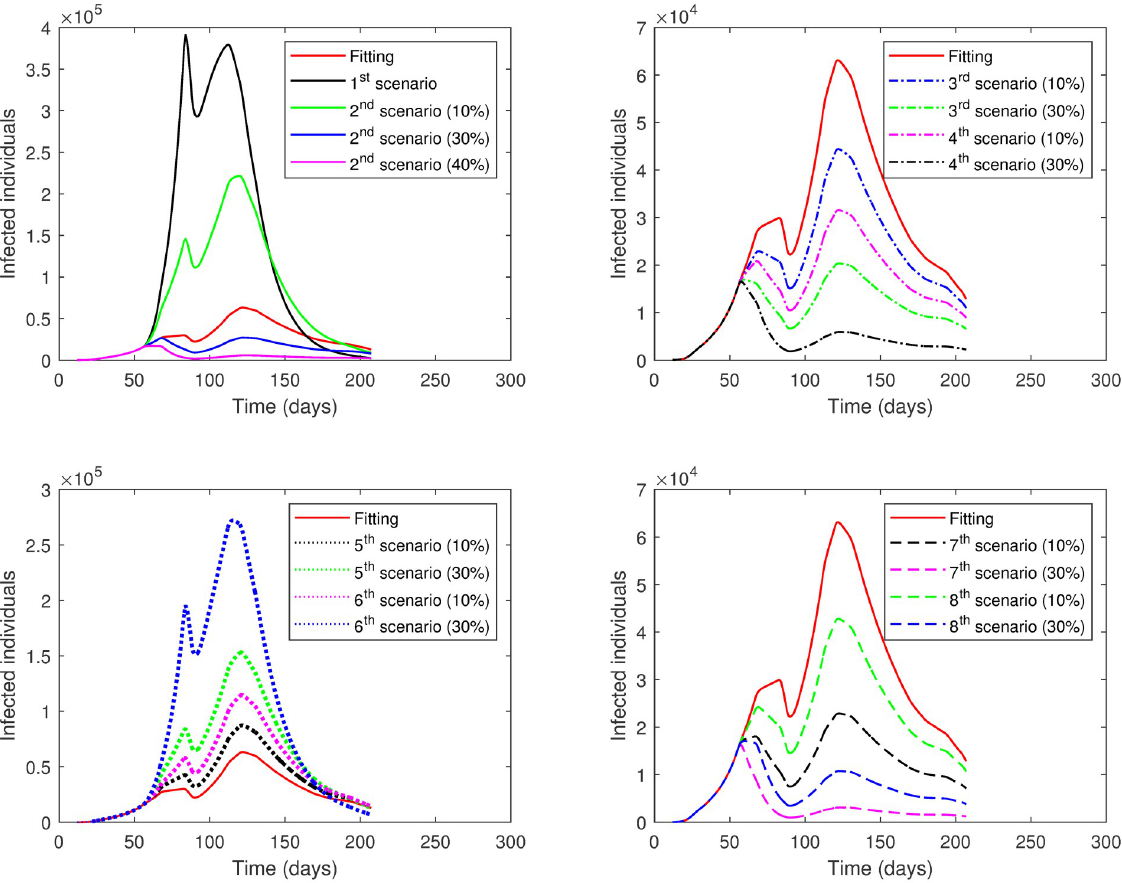
Fig 10. The numerical solution of model (1) for infected compartment vs. time with different scenarios of Phase 4 in the First Case: 1 st scenario, no lockdown is implemented; 2 nd scenario, no lockdown while SD increases; 3 rd scenario, lockdown increases; 4 th scenario, SD increases; 5 th scenario, lockdown decreases; 6 th scenario, SD decreases; 7 th scenario, lockdown and SD increases; 8 th scenario, lockdown decreases and SD